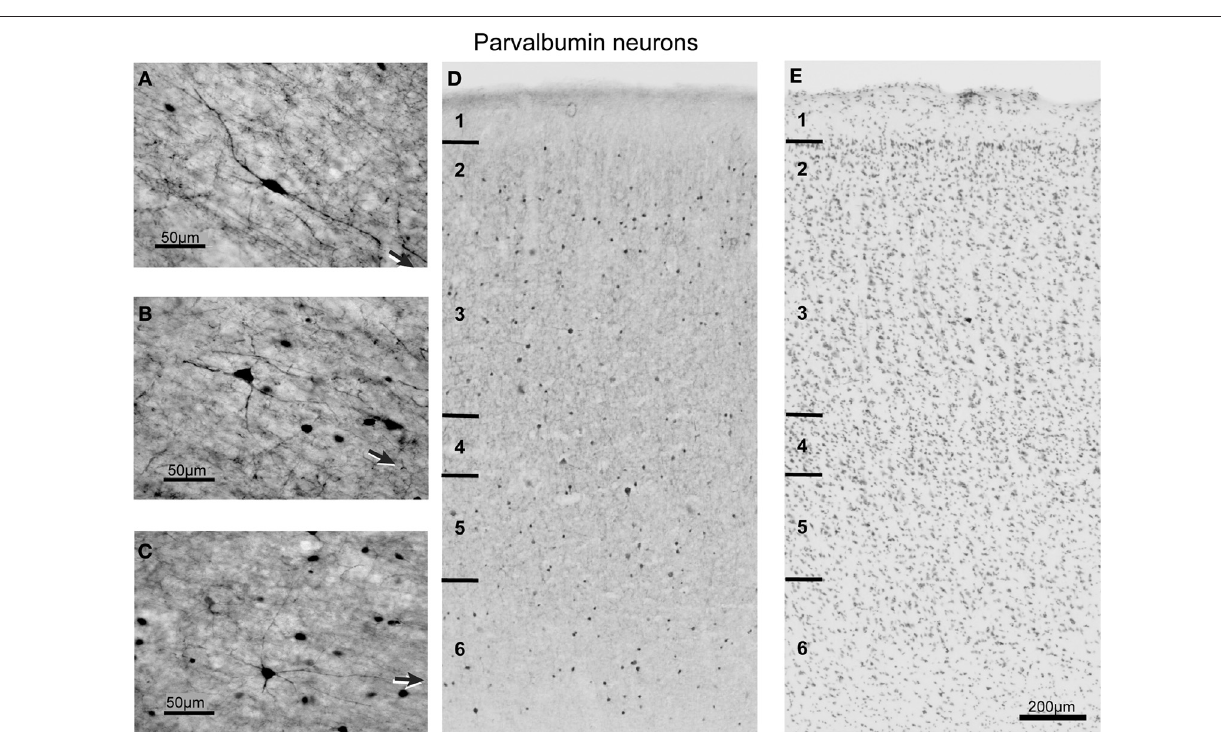
FIGURE 6 | Brightfi eld photomicrograph of PV-labeled neurons in FEF. Note the quite uniform distribution of PV-labeled neurons across the layers. Conventions as in Figure